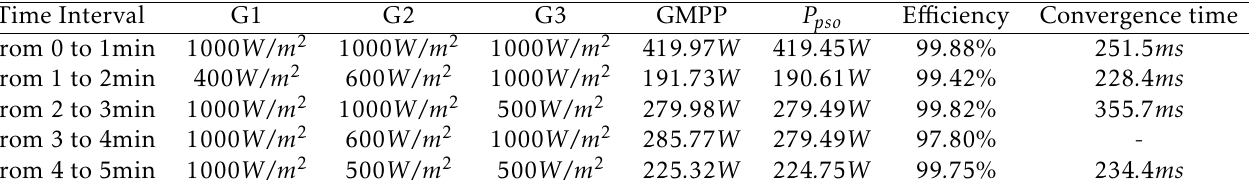
Table 8. Evaluation of the effectiveness of the MPPT for each P-V curve in the simulation